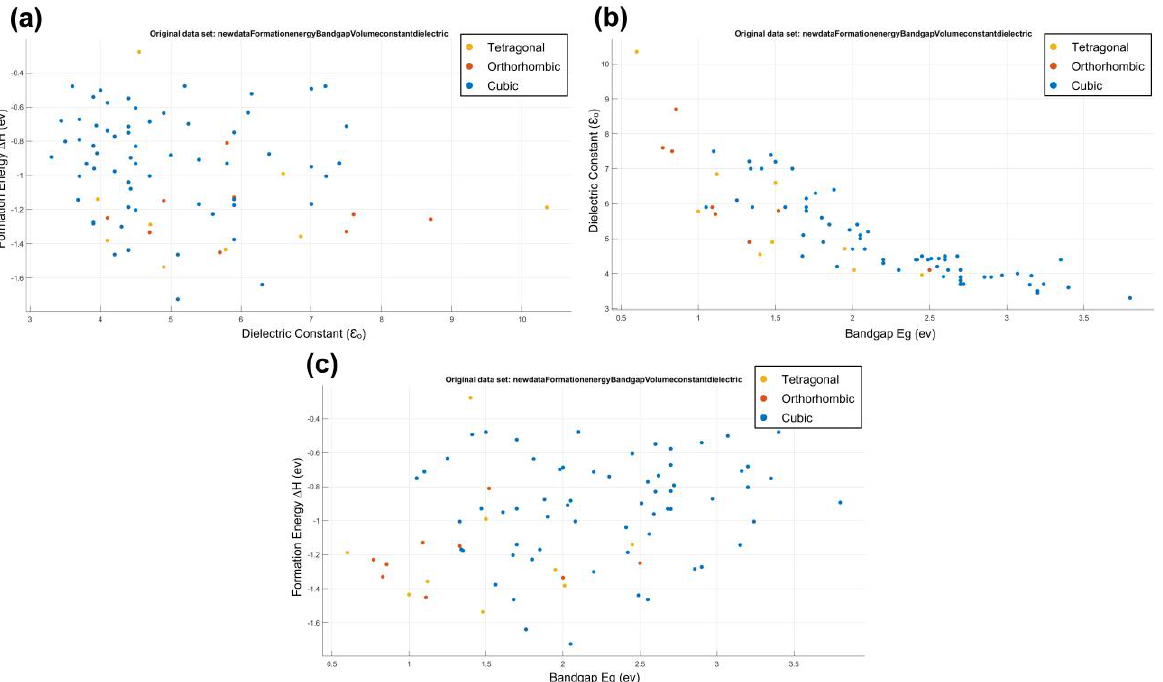
Figure 3. Formation energy and structural stability: the relationship between attributes obtained using MATLAB. ( a ) Formation energy vs dielectric constant, ( b ) Dielectric constant vs band gap and ( c ) formation energy vs band gap.